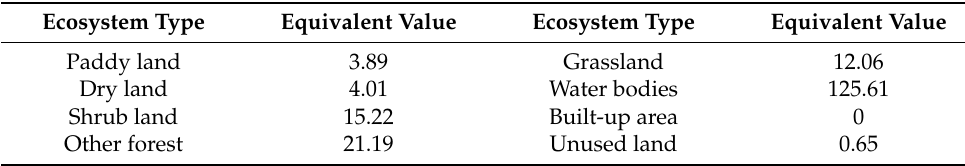
Table 2. Ecosystem service equivalent value per unit area.